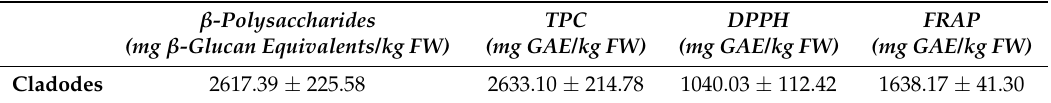
Table 2. Total β -polysaccharides, total phenolic content (TPC), and antioxidant activities (DPPH radical scavenging and FRAP reducing power) in cladodes extracts. The data are presented as mean values ± standard deviation ( n = 5). Results for TPC, DPPH and FRAP are expressed as gallic acid equivalents (GAE), whilst results for β -polysaccharides are expressed as β -glucan equivalents. FW = fresh weight. β -Polysaccharides TPC DPPH FRAP Cladodes 2617.39 ±